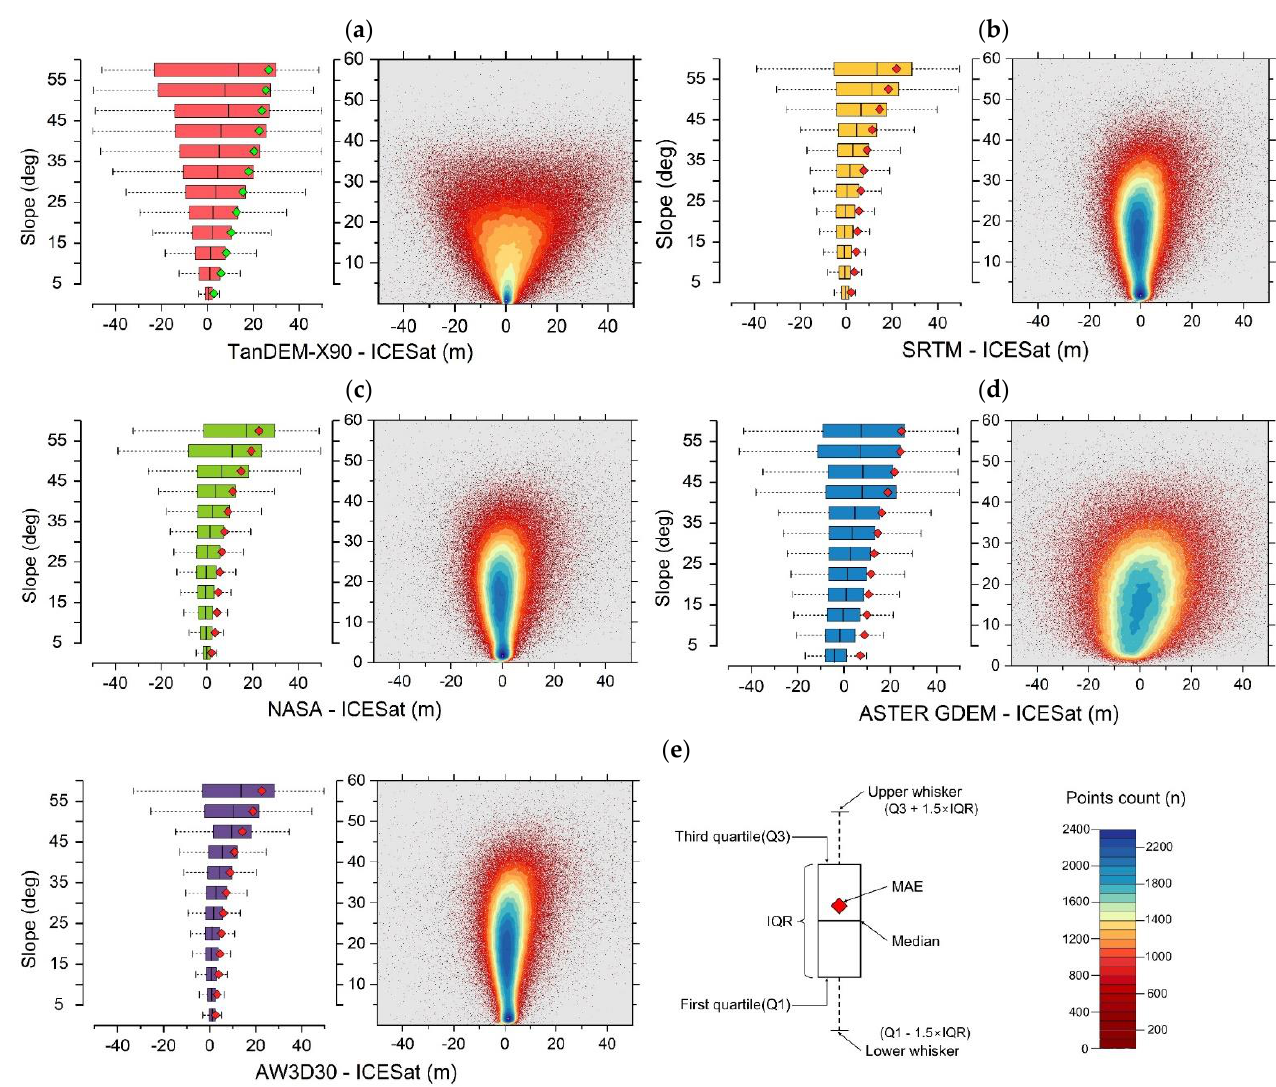
Figure 6. The differences (i.e., bias) between five DEM products and ICESat/GLAS GCP points, shown as boxplots (with 5 degree intervals) and hex-bin scatterplots according to slope change: ( a ) TanDEM-X90, ( b ) SRTM, ( c ) NASA, ( d ) ASTER GDEM, ( e ) AW3D30. Different vegetation sparsity under the same landcover types, that is, different vege- tation coverages, will also cause changes in the phase center of reflected electromagnetic waves, resulting in significant differences in DEM errors [33]. Figure 10 shows the DEM errors vary with vegetation coverage. The box and hex-bin scatterplots show the DEM differences with FVCover. When 0 ≤ FVCover < 0.1, the MAE of these five DEMs has a high value. One explanation is that when the FVCover value is low, it includes glaciers/bare areas, increasing MAE . When 0.1 ≤ FVCover < 0.4, except for TanDEM-X90, the MAE values of the other DEMs remain stable and do not change with FVCover. When FVCover ≥ 0.4, the quality of all DEMs decreases slowly with increasing